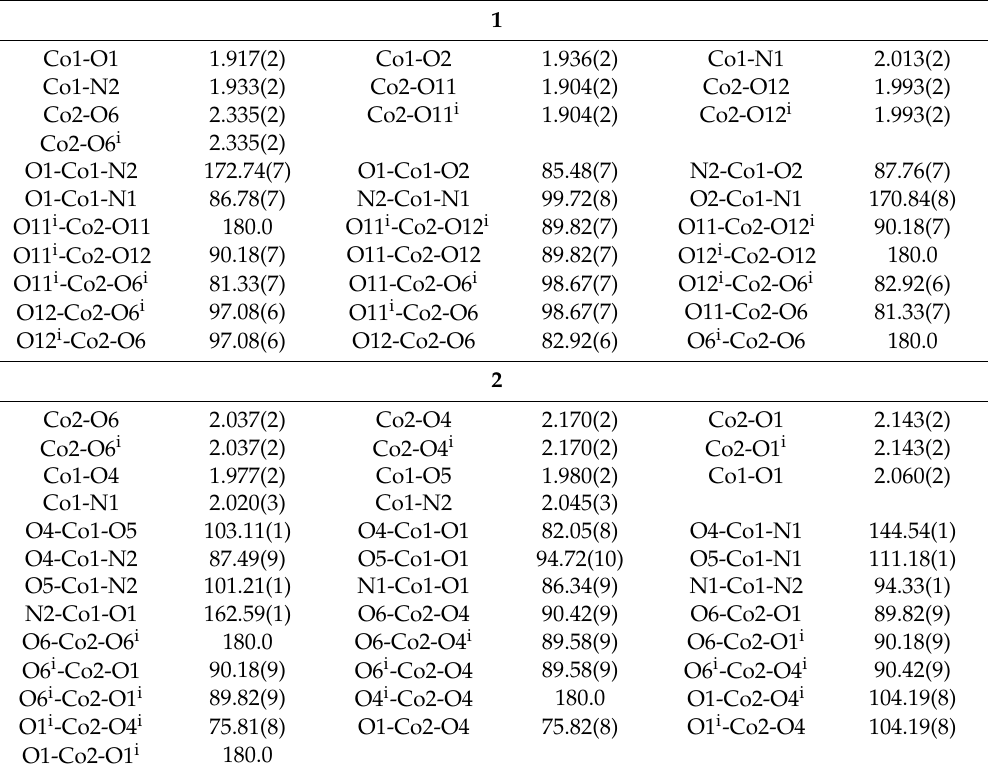
Table 3. Selected bond distances (Å) and angles ( ◦ ) for complexes 1 and 2